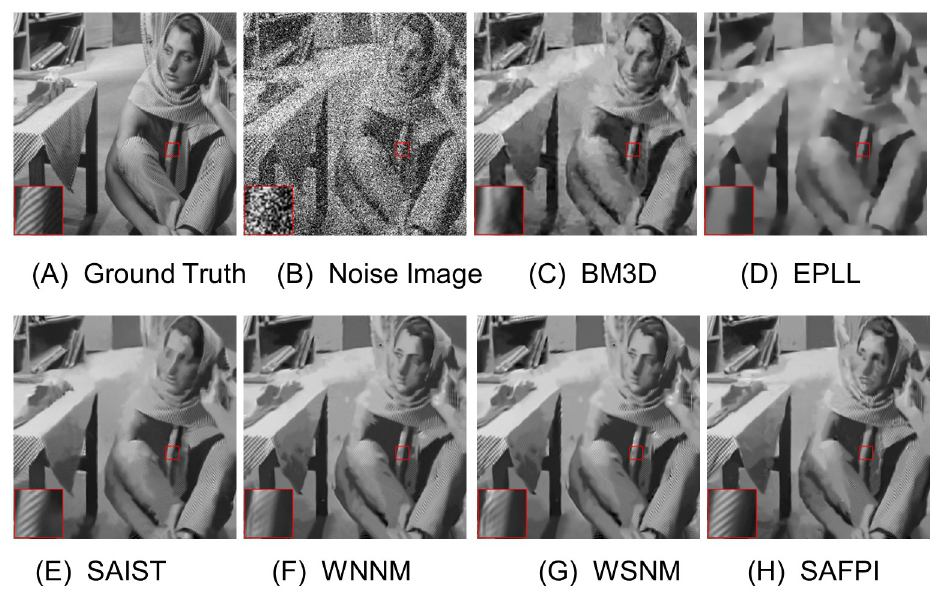
Fig 7. Denoising results on image Barbara by different methods (noise level σ Image (C) BM3D, PSNR = 23.62 (D) EPLL,PSNR = 22.14 (E) SAIST, PSNR = 23.98 (F) WNNM, PSNR = 24.39 (G) WSNM, PSNR = 24.43 (H) SAFPI, PSNR = 24.5.